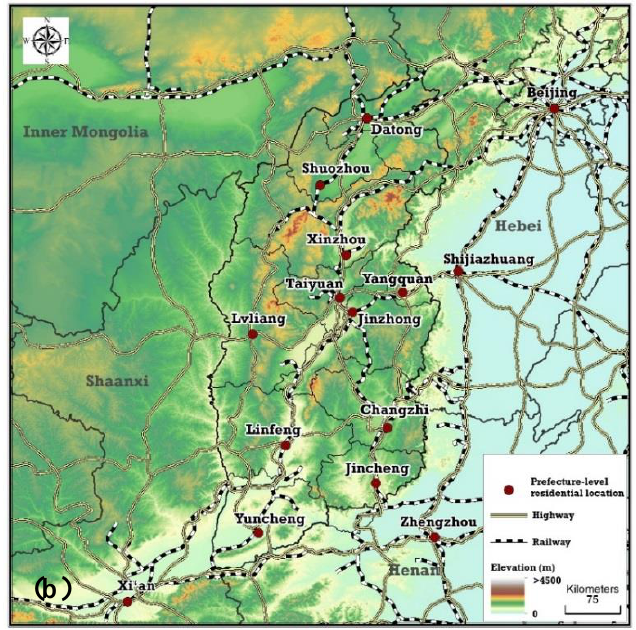
Figure 1. Location of Shanxi Province in China and the 11 prefecture-level administrative subdivisions of Shanxi Province ( a ); terrain and traffic network of highways and railways over Shanxi and its environs ( b ).